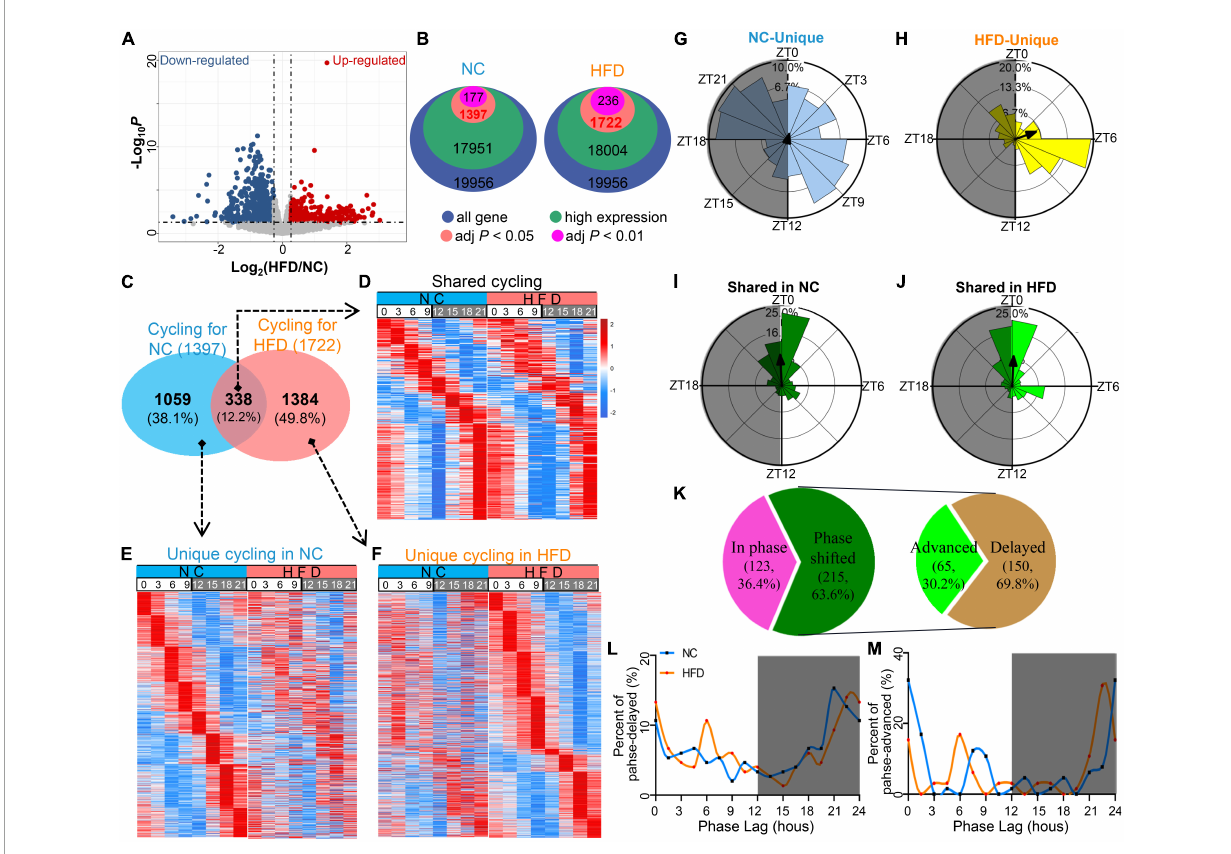
FIGURE2 High-fat diet (HFD) reprograms the characteristics of the circadian transcriptome in murine MGs. (A) Volcano plot of RNA-seq data for NC- and HFD-fed MG genes. The red and blue dots denote ≥ 1.2-fold or ≤ 0.83-fold changes in expression between the NC-fed and HFD-fed MGs, respectively. (B) The number of rhythmic genes in NC- and HFD-fed MGs under different threshold conditions in the JTK_ algorithm. (C) Venn diagram showing the gene sets of the MGs of NC- and HFD-fed mice (JTK algorithm, adjusted P < 0.05 and expression ≥ 0.1). n = 3 mice per group per time point at 3-h intervals. n = 24 mice per group. (D) Heatmaps visualizing the expression levels of 338 shared rhythmic genes in the MGs of NC- (left) and HFD-fed (right) mice at different ZT points at 3-h intervals throughout the circadian cycle. The expression levels were indicated by a color bar ranging from blue to red, with the expression range normalized to ± 2. (E) Heatmaps visualizing the expression levels of 1,059 rhythmic genes unique in the MGs of NC-fed mice at various ZT points at 3-h intervals throughout the circadian cycle. (F) Heatmaps visualizing the expression levels of 1,384 rhythmic genes unique in the MGs of HFD-fed mice at various ZT points at 3-h intervals throughout the circadian cycle. (G–J) Phase analysis of rhythmic genes in the MGs of NC- and HFD-fed mice. Gray shading: dark phase. (K) Phase analysis of 338 shared rhythmic genes in